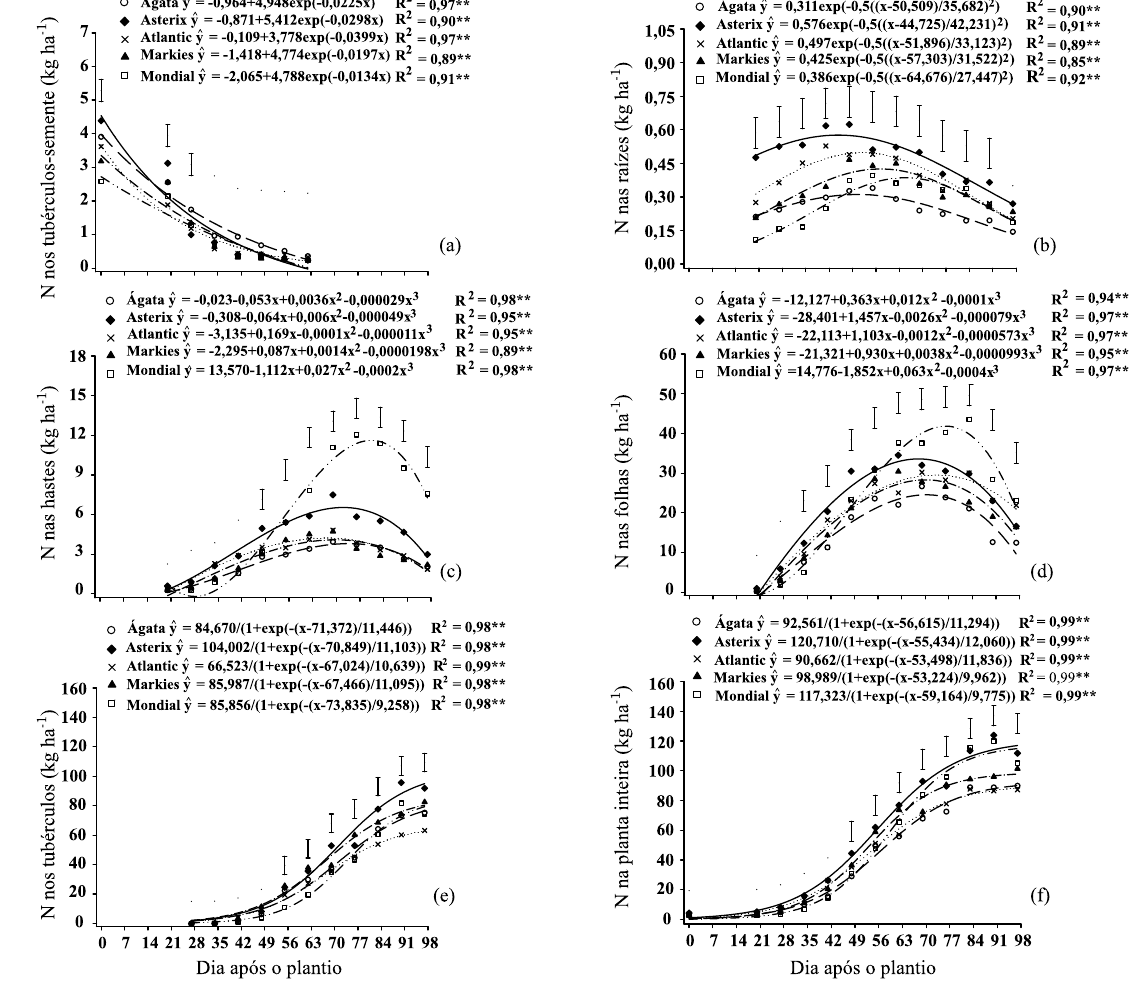
Figura 2. Quantidade de N nos tubérculos-semente (a), raízes (b), hastes (c), folhas (d), tubérculos (e) e na planta inteira (f) de cultivares de batata ao longo do ciclo. ** significativo a 1 % pelo teste F. Barras verticais indicam o valor de DMS pelo teste de Tukey a 5